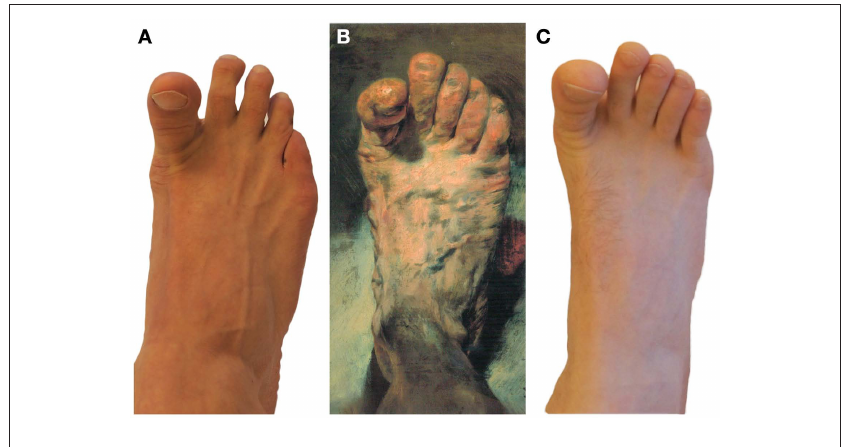
Figure 1 | (A) A foot of a proband – a Babinski sign or a voluntary extension of a great toe? (A solution is found in the Supplementary material). (B) “The painter’s Foot” by Adolph von Menzel